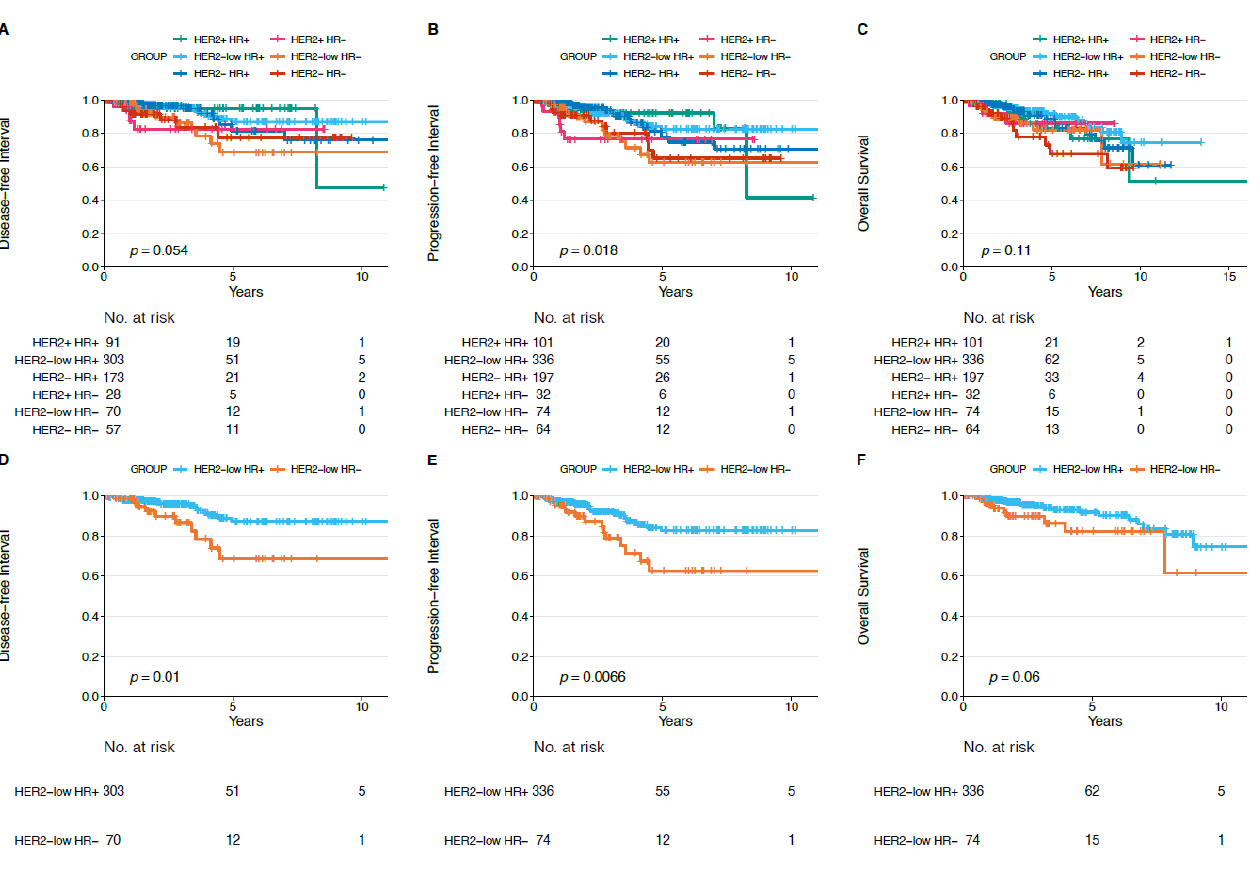
Figure 7. ( A – F ). Disease-free interval (DFI), progression-free interval (PFI), and overall survival (OS) according to breast cancer subtypes ( A – C ), and in HER2-low/HR+ versus HER2-low/HR− breast tumors ( D – F ). Abbreviations: HR: hormone receptor.